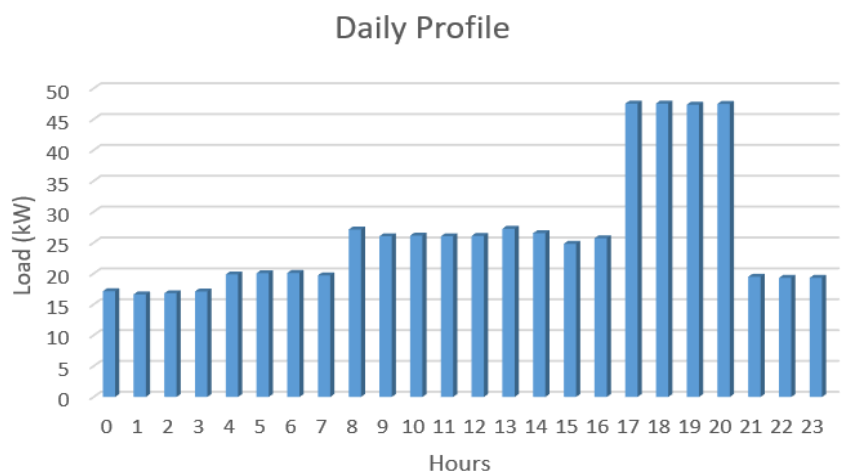
Figure 3. Hourly load